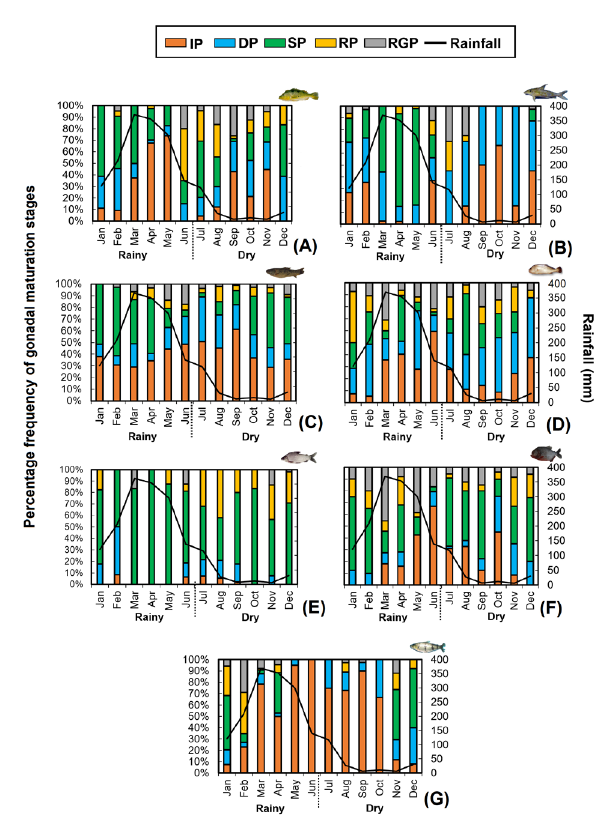
FIGURE 5 | Relative frequency of gonadal maturation stages during the rainy and dry seasons. ( A ) Cichla monoculus ; ( B ) Hassar affinis ; ( C ) Hoplias malabaricus ; ( D ) Plagioscion squamosissimus ; ( E ) Prochilodus lacustris ; ( F ) Pygocentrus nattereri ; and G . Schizodon dissimilis , caught in Baixada Maranhense Protection Area, between January 2012 and December 2016. Immature (IP); Developing phase (DP); Spawning capable (SP); Regression (RP); Regeneration (RGP), F (Female) and M